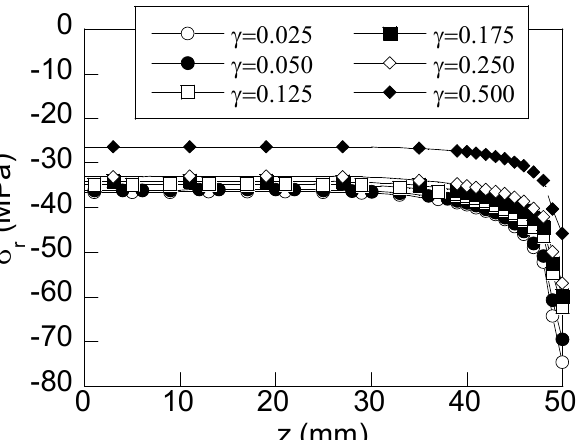
Figure 8. Axial distributions of the radial stress at the interface contact ring/shaft for diverse values of the thickness ratio.